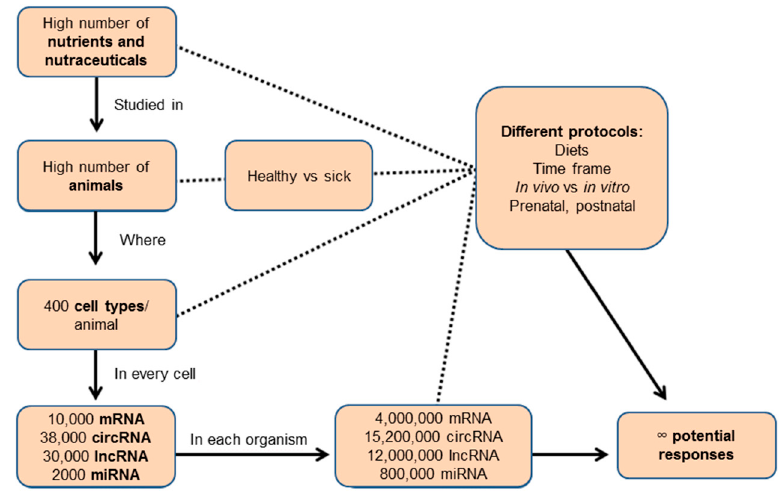
Figure 3. Potential transcriptomic changes in different cells upon exposure to the Mediterranean diet.